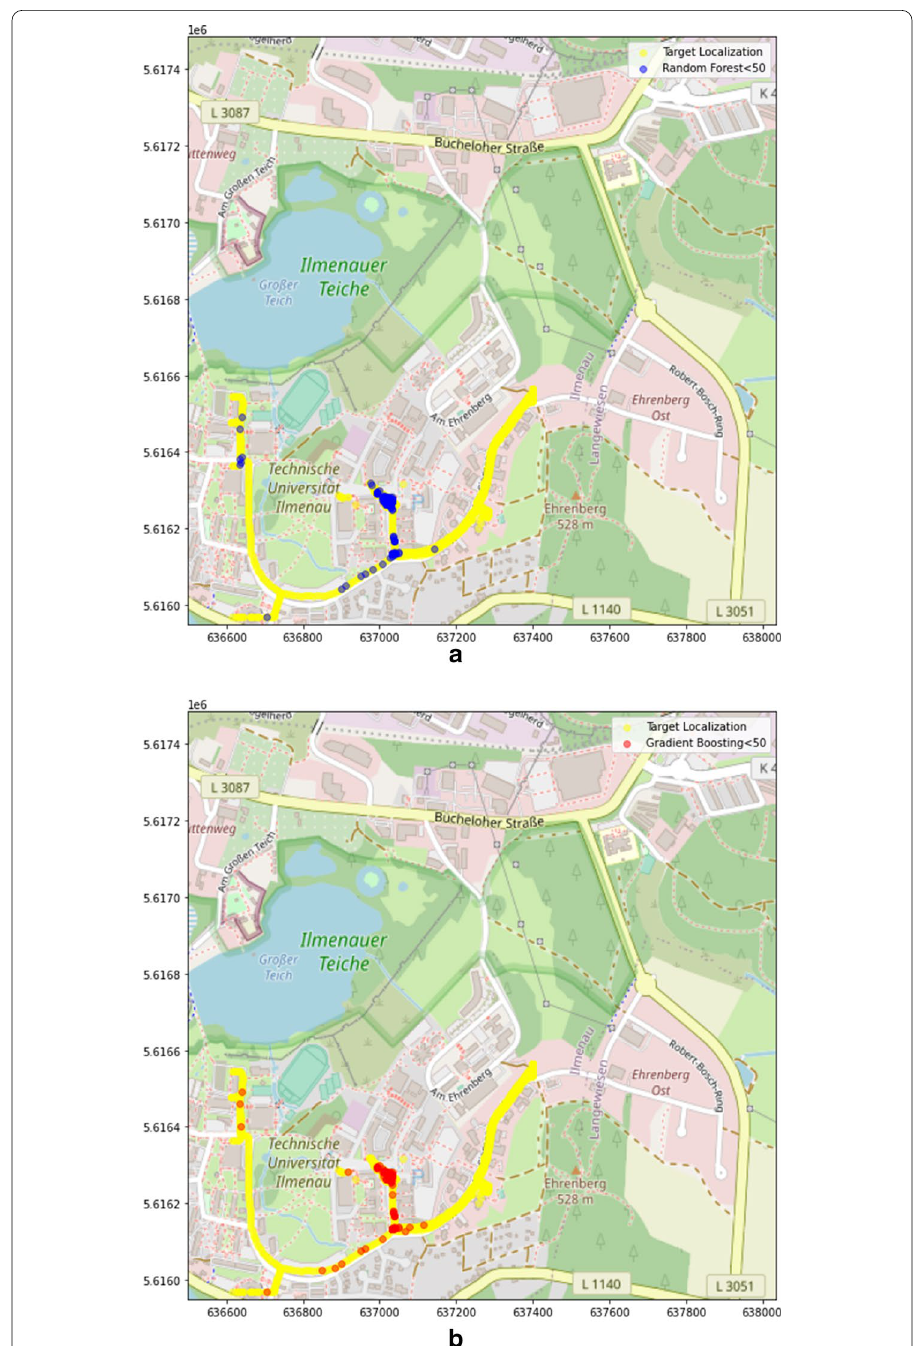
Fig. 17 Position estimation experiment (with noise level equal to 2) where the error was less than 50 m for a random forest (blue) and b gradient boosting (red), the yellow line is the positions assumed by the